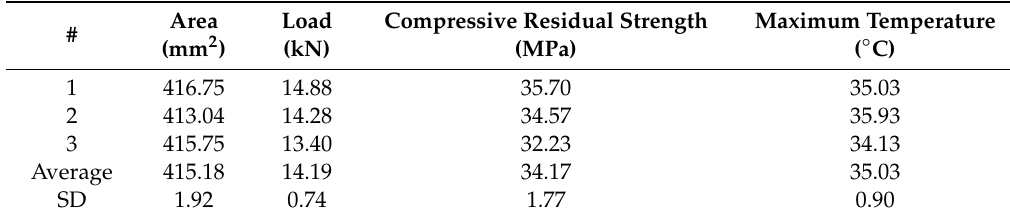
Table 14. CAI results of Type